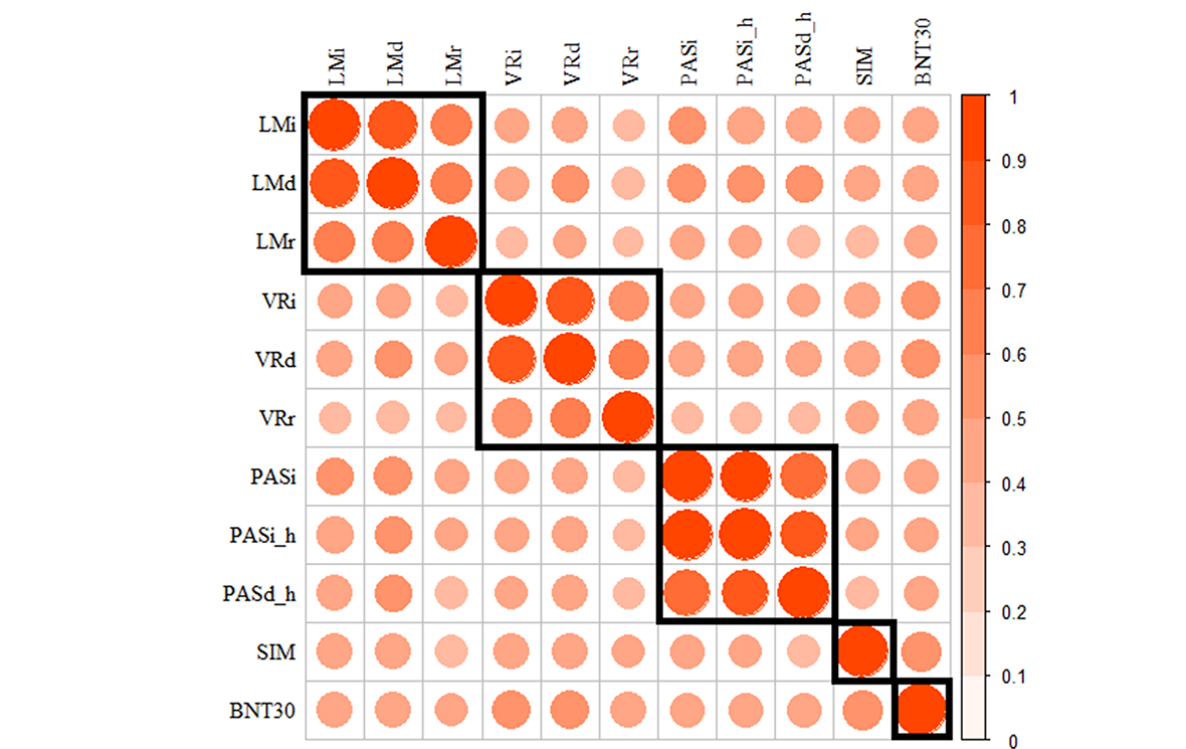
Figure 3. Correlation clusters between different neuropsychological tests. The red rectangles represent different clusters of tests. Bigger and redder nodes represent higher correlation, whereas whiter and smaller nodes represent lower correlation. BNT30: Boston Naming Test 30 item Even